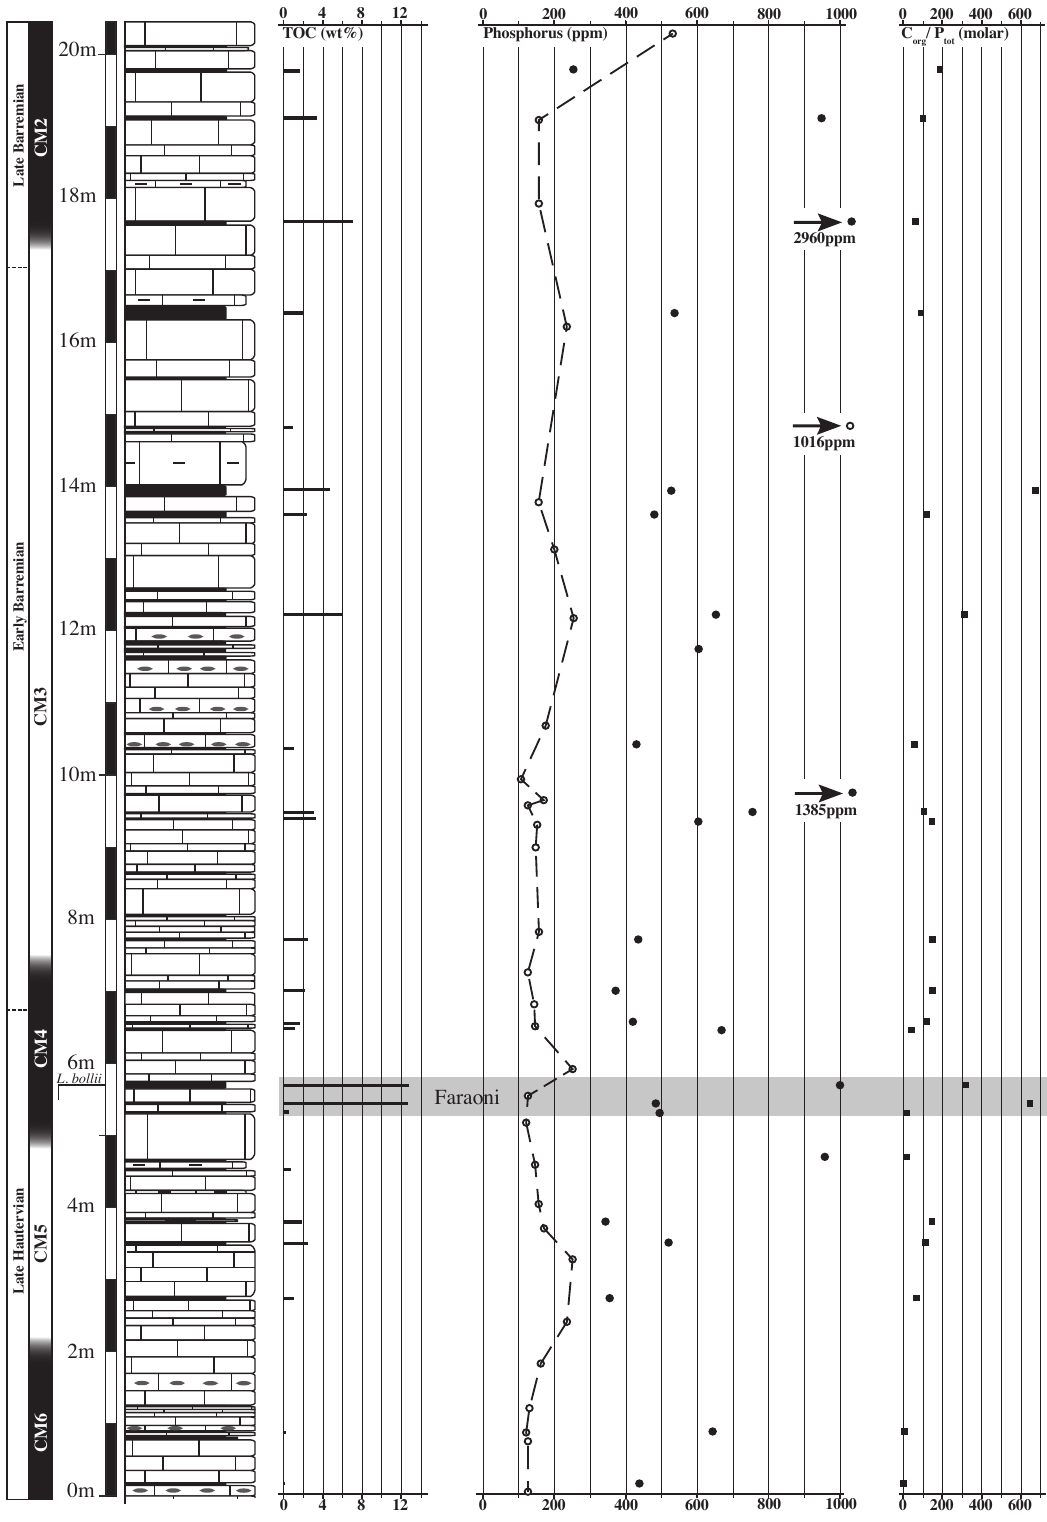
Föllmi et al., Fig. 2 Fig. 2. The Breggia section: TOC contents in mudstone samples, phosphorus contents in carbonate (open circles) and mudstone samples (closed circles), and calculated C org :P tot molar ratios. The grey band indicates the position of the Faraoni level. The magnetostratigraphy is after Channel et al.